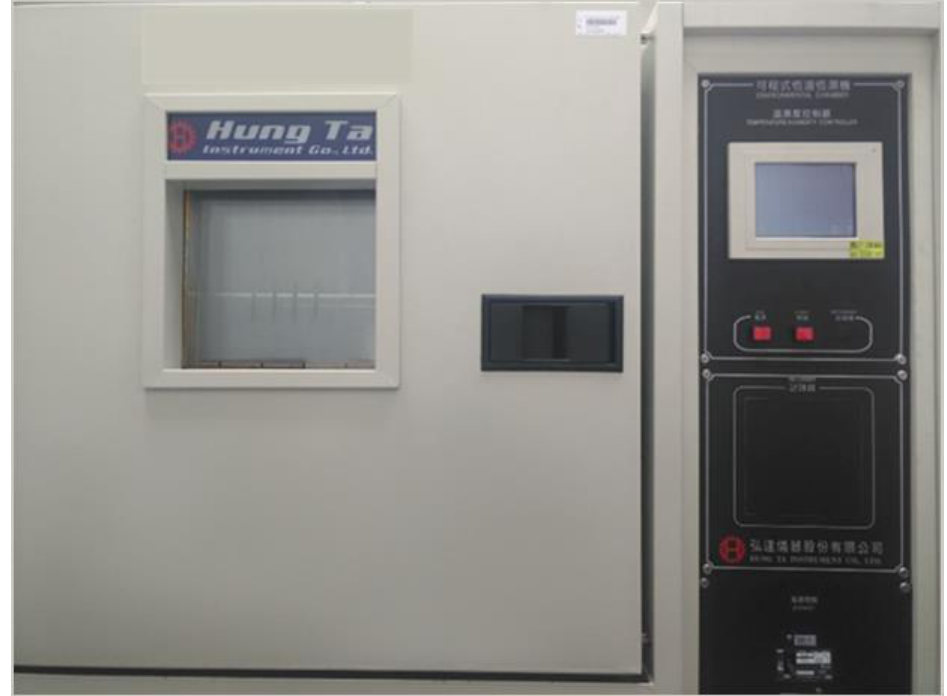
Figure 9. Hung ta HT-8045A Environmental Chamber.